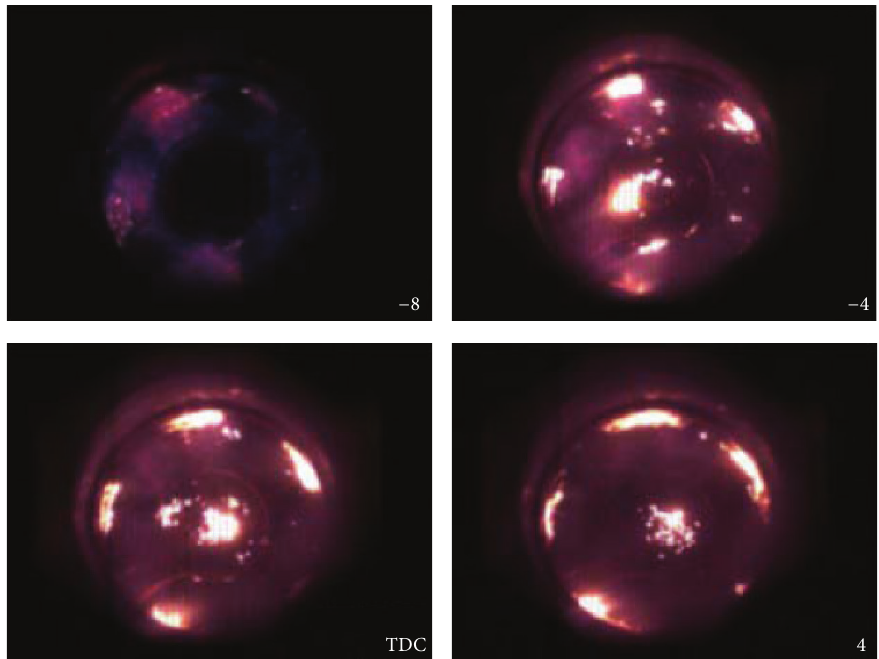
Figure 10: Direct-imaging of luminous DI-diesel combustion; single injection, injection timing = − 15 ∘ CA ATDC, injection quantity = 11.5mm 3 , injection pressure = 120MPa, and injection angle = 150 ∘ [66].